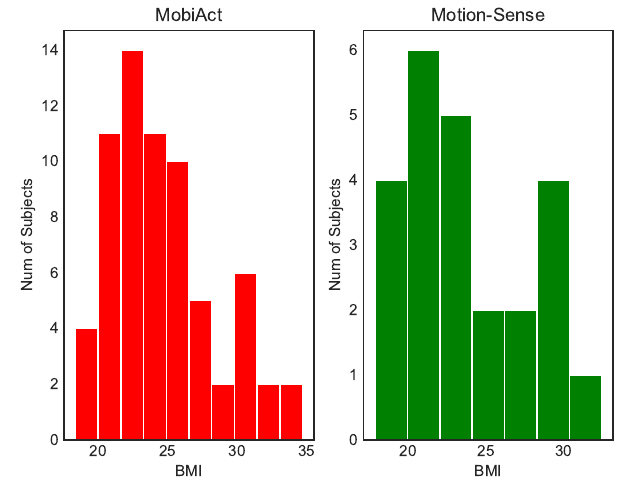
Figure 2. The BMI of the two